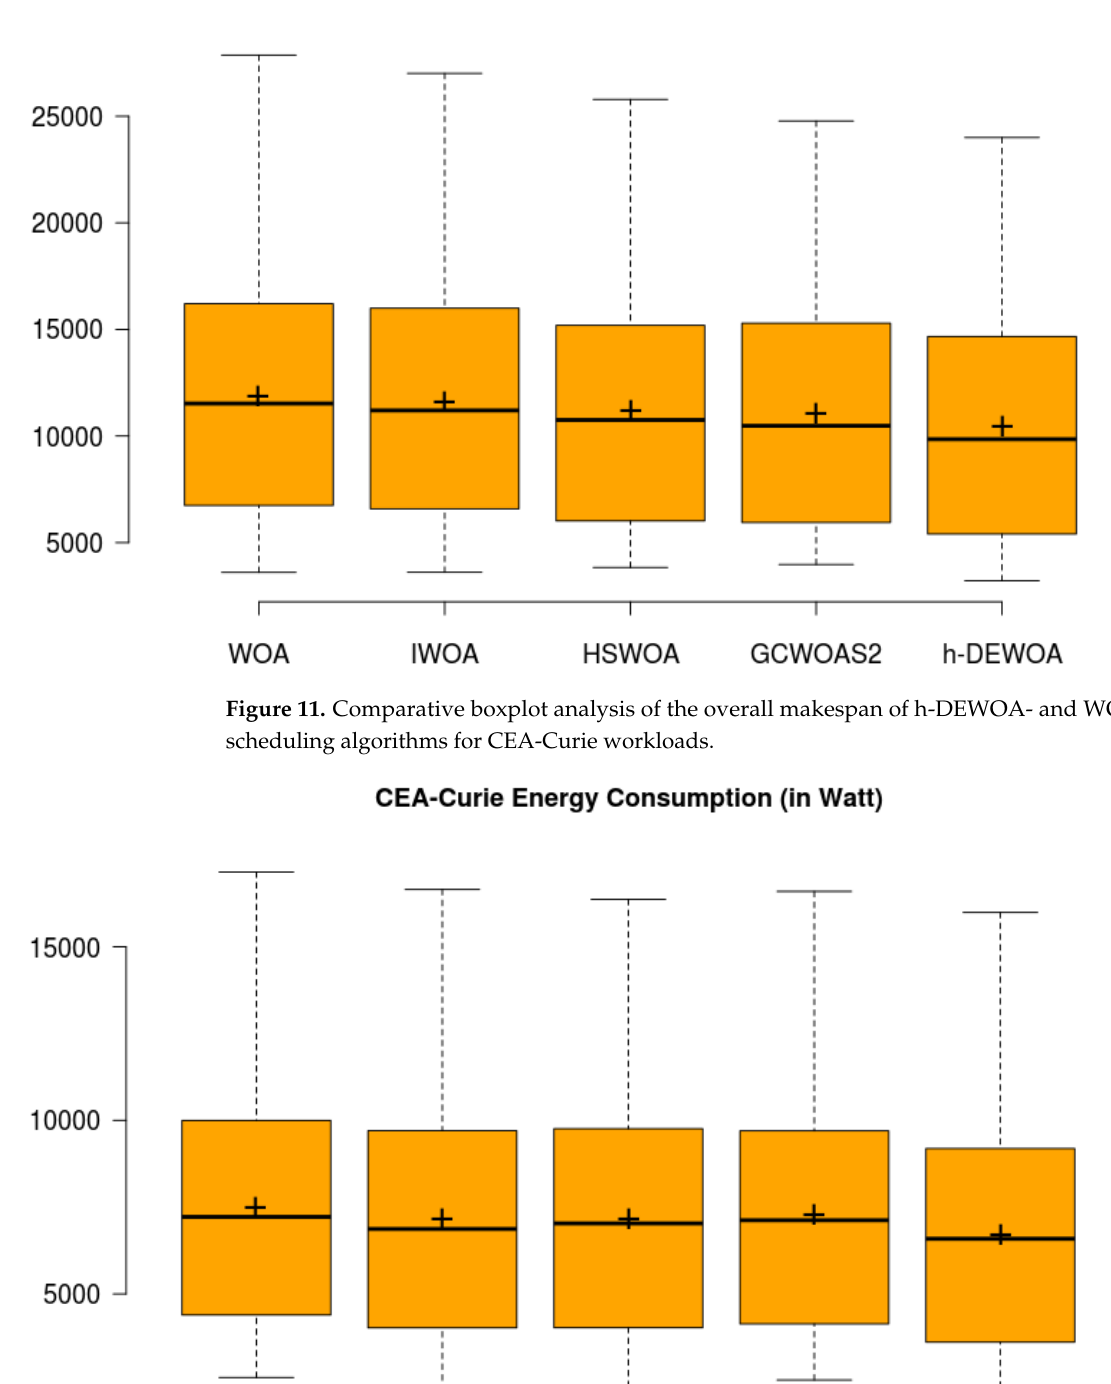
Figure 13. Comparative boxplot analysis of the overall makespan of h-DEWOA- and WOA-based scheduling algorithms for HPC2N workloads.